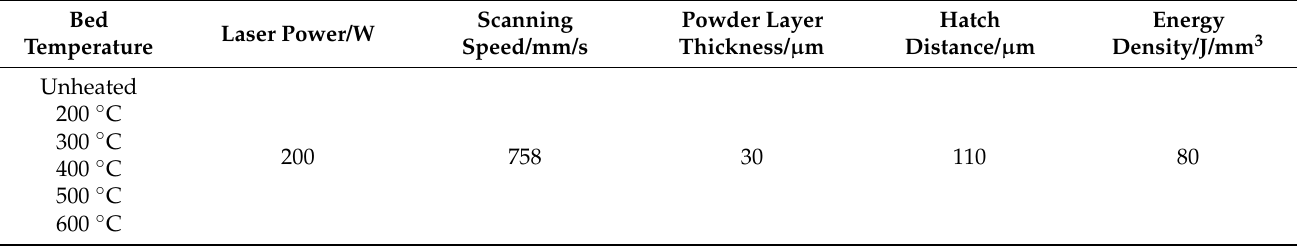
Figure 1. ( a , b ) morphology; ( c ) partial size distribution of the Ti-6Al-4V alloy powder. Table 2. Laser powder bed melting fabricated Table 1. Powder elemental composition (weight %).